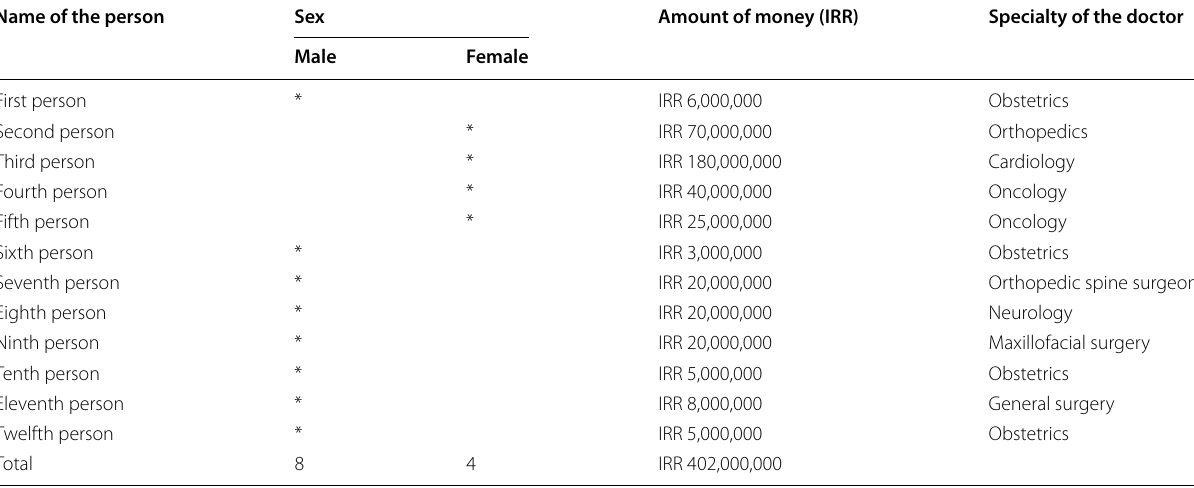
Table 2 Data related to the amount of payment and type of